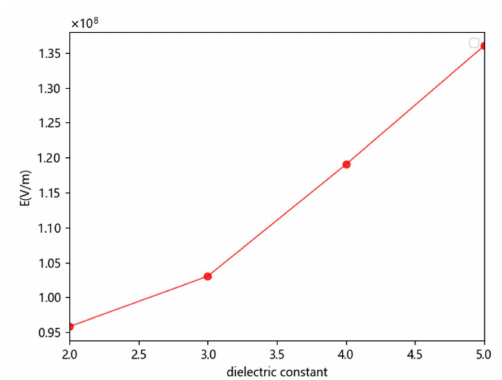
Figure 12. Variation of electron concentrations with ε r .